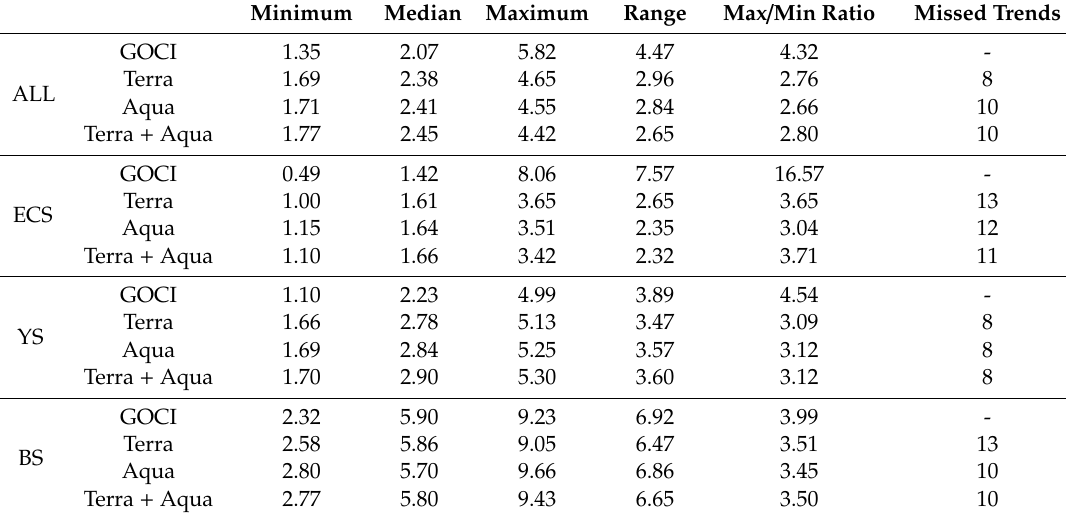
Table 4. Monthly statistics of TSS (g/m3) variations from GOCI, “simulated” Terra, Aqua and Terra + Aqua observations.